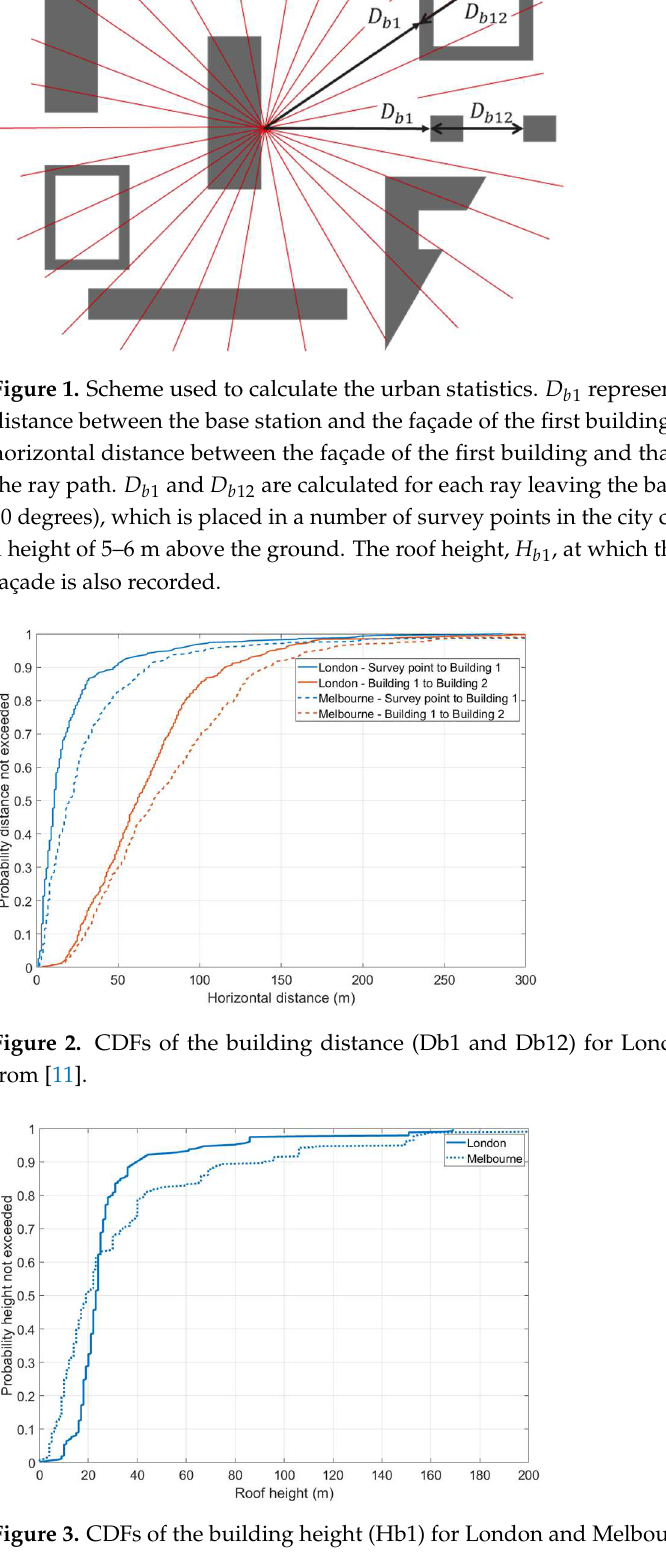
Figure 3. CDFs of the building height (Hb1) for London and Melbourne, extracted from [11].